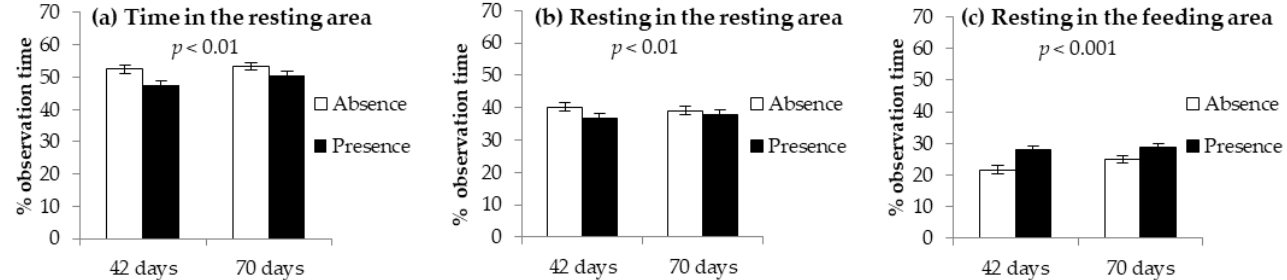
Figure 2. Time (% of observation time) spent ( a ) in the resting area, ( b ) resting in the resting area, ( c ) and resting in the feeding area of the parks by growing rabbits kept in collective parks without (absence) or with (presence) gnawing hay blocks at 42 and 70 days of age (significant interactions age × absence/presence of gnawing blocks). Data are reported as means ± standard deviations.